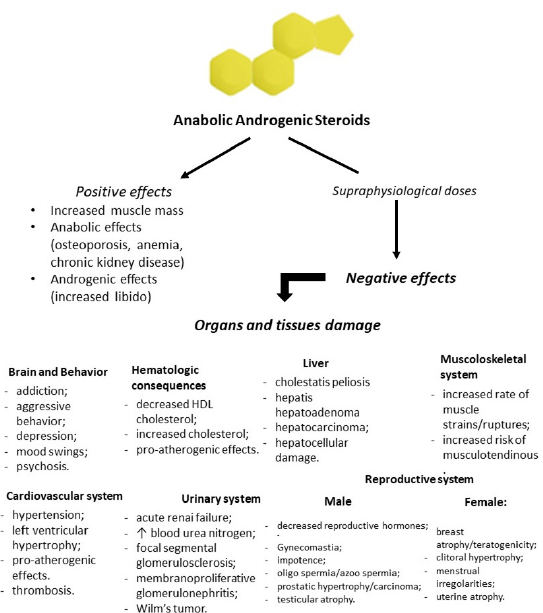
Figure 2. Flowchart of positive and negative effects of anabolic-androgenic steroid (AAS) administration. Prolonged and high doses of testosterone and his derivatives lead to serious consequences in all body tissues and organs.